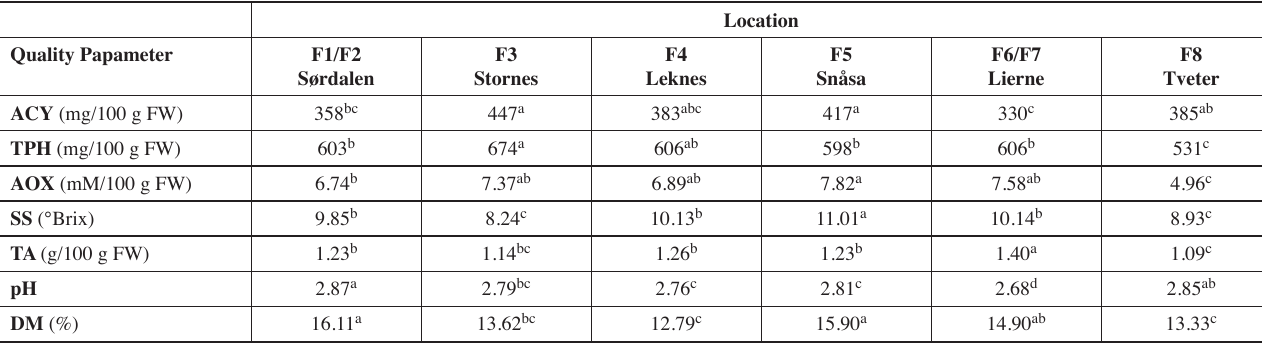
Tab. 2: Berry quality at different field locations based on corresponding measurements of total anthocyanins (ACY), total phenols (TPH), antioxidant activity (AOX), soluble solids (SS), titratable acidity (TA), pH and dry matter (DM) as averages of the years 2008 to 2011. Letters indicate significant differences ( P < 0.05) between locations.